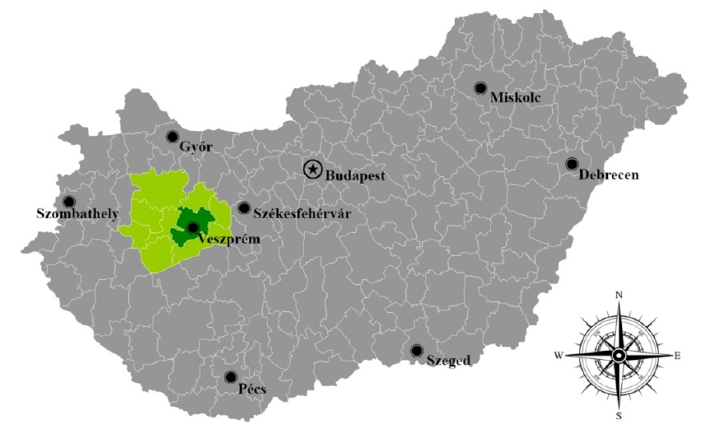
Figure 1: Veszpr´em district (dark green) within Veszpr´em County (light green) and